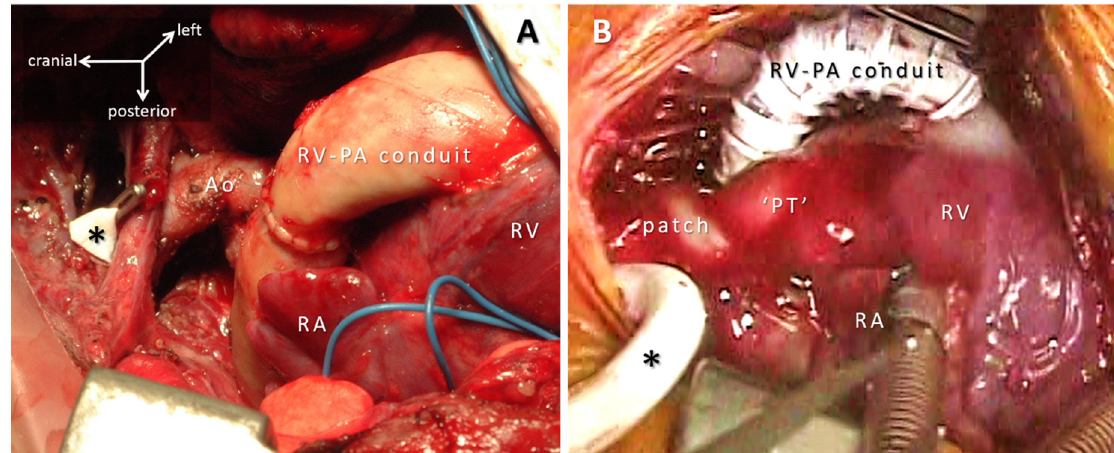
Figure 4. Various biomaterials utilized during complex neonatal cardiac reconstructive surgeries. Images taken from the intraoperative video recording. ( A ) Right ventricle-to-pulmonary artery (RV-PA) connection with valved bovine conduit. ( B ) RV-PA connection with ringed expanded polytetrafluoroethylene (ePTFE) conduit; the pulmonary trunk serves as the systemic outlet of the heart and it is connected to the aortic arch, ascending and descending aorta in a complex anastomosis augmented with autologous pericardium patch. During the arch repair, selective cerebral perfusion is performed through the ePTFE tube (*) connected to the innominate artery. Abbreviations: Ao: ascending aorta; PT: pulmonary trunk; RA: right atrium; RV: right ventricle.